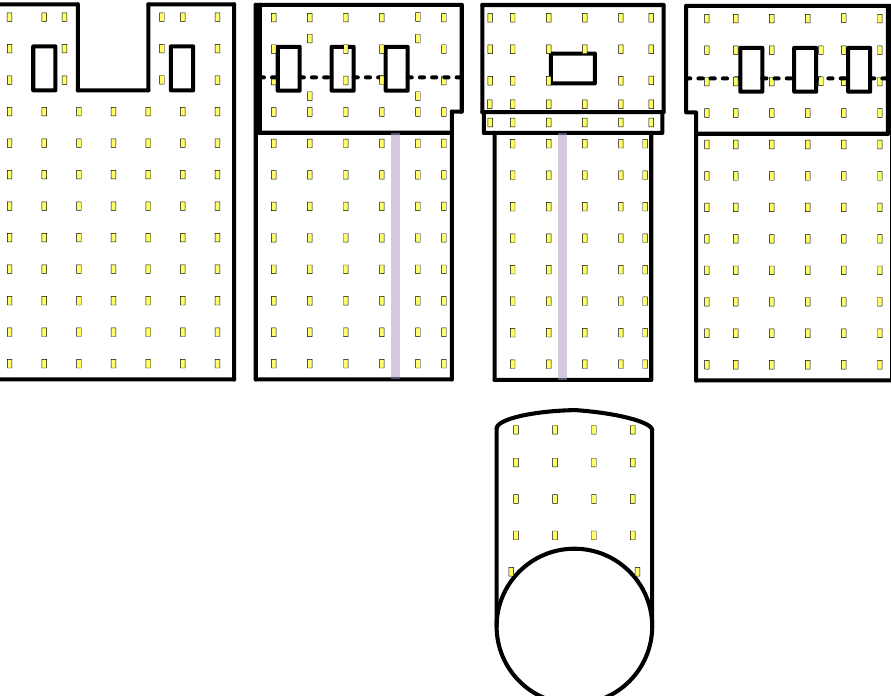
Fig. 3. In situ total gamma surface mapping of the inner pool (top) walls and fl oor (bottom). The small rectangles indicated the measurement locations. The grey lines mark the region of the storage container (also called “ Poubelle ”